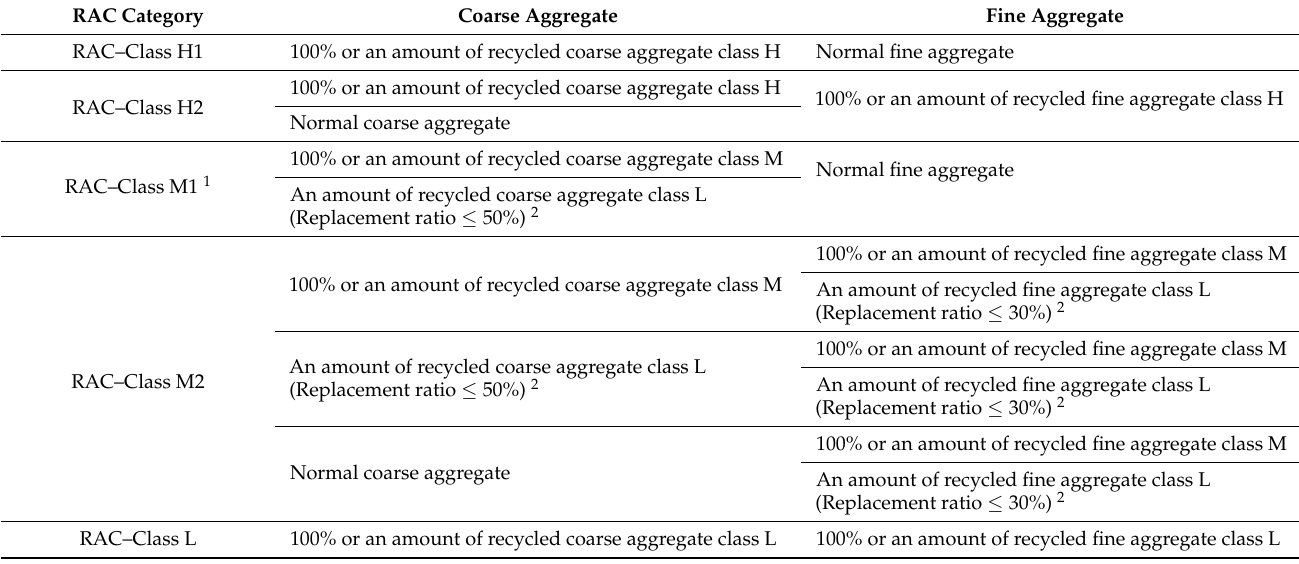
Table 1. Types of RAC and combination of aggregate